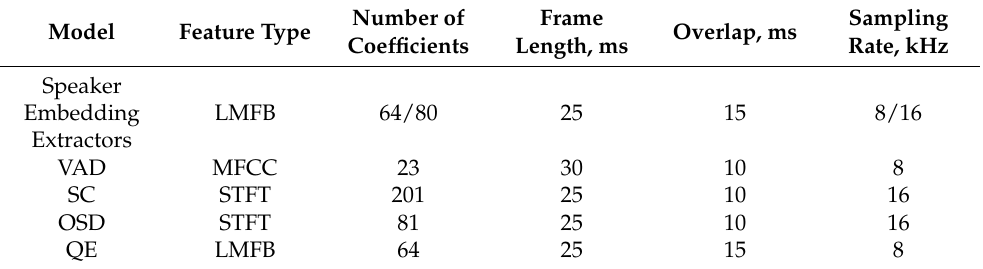
Table 1. Types of applied audio